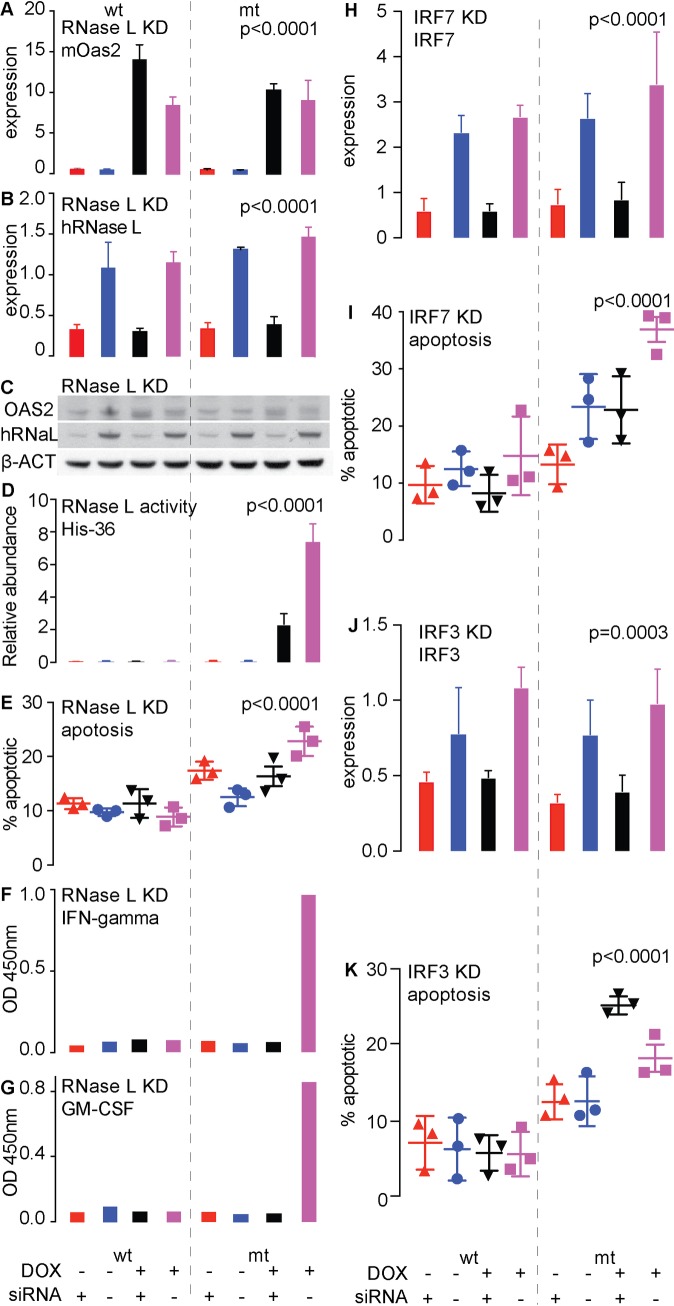
Effects of knockdown of RNASEL, IRF7 and IRF3 on the effects of inducible expression of either mutant (mt) or wild type (wt) mouse Oas2 in T47D cells.(A-G) Provide the context of RNase L knockdown. (A-C) Demonstration of Doxycycline (DOX)-inducible expression of wt or mt Oas2 in T47D cells, and effective knock-down of RNASEL (RNaL) in mt or wt expressing T47D cells by quantitative PCR (B) or western blot (C). (D) Effect of the induction of mt or wt OAS2 on RNase L activity (E) Effects of induction of mt and wt Oas2 expression on apoptosis. (F) Effects of these treatments on interferon gamma protein production. (G) effects of these treatments on GM-CSF production. (H) Demonstration of effective knockdown of IRF7. (I) Effects of knockdown of IRF7 on mutant or wild type Oas2-driven apoptosis. (J) Demonstration of knockdown of IRF3. (K) Effects of knockdown of IRF3 on mutant or wild type Oas2-driven apoptosis.